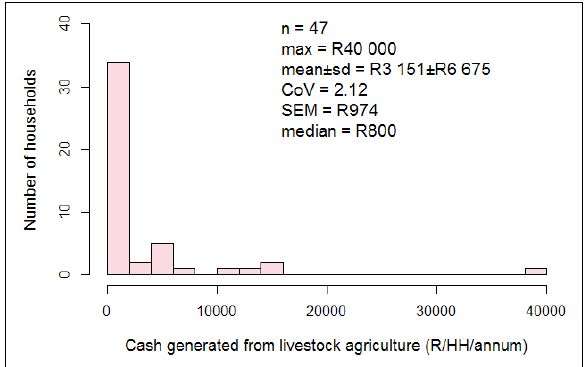
Values of cash (ZAR) generated from selling livestock and livestock products per household (HH) per annum across a sample size of 590 households in 2010, in Bushbuckridge, South Africa Off-farm income